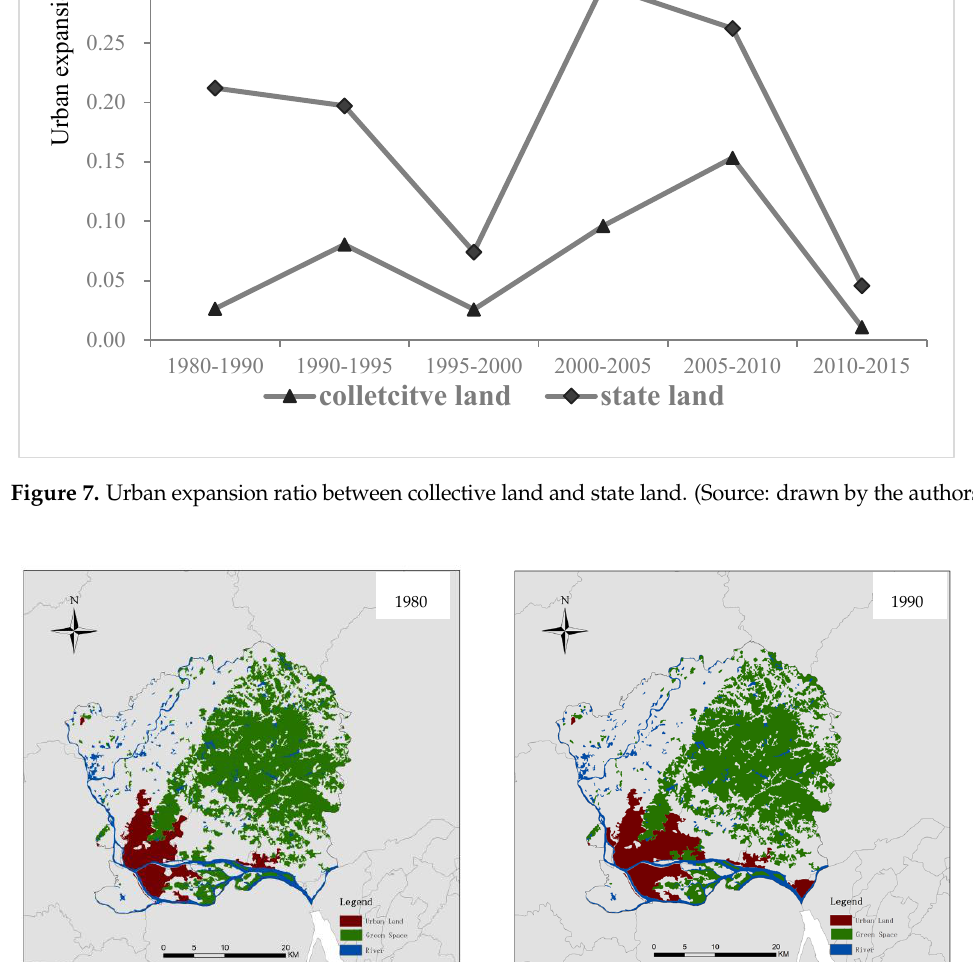
Figure 8. Urban expansion from 1980 to 1990. (Source: drawn by the authors).